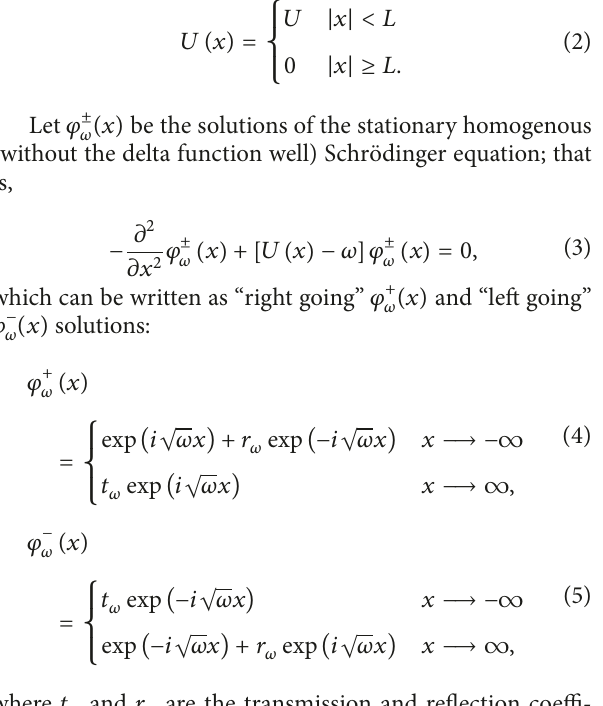
> Ω ; however, for specific act ≅ act